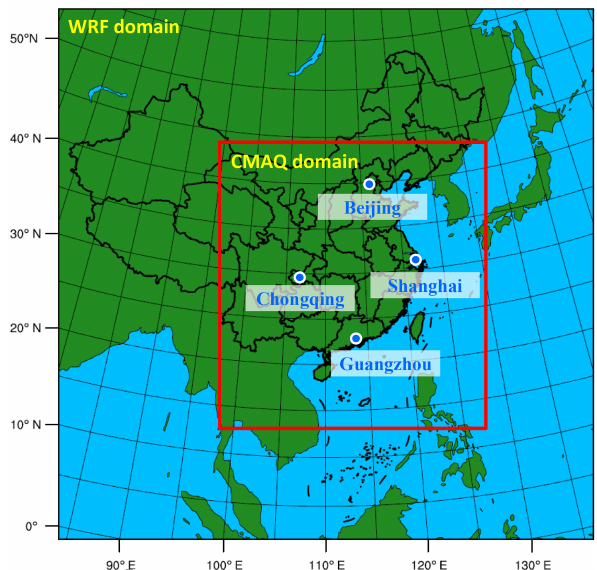
Figure 3. Modeling domain of WRF/CMAQ and the locations of typical sites: Beijing, Shanghai, Guangzhou, and